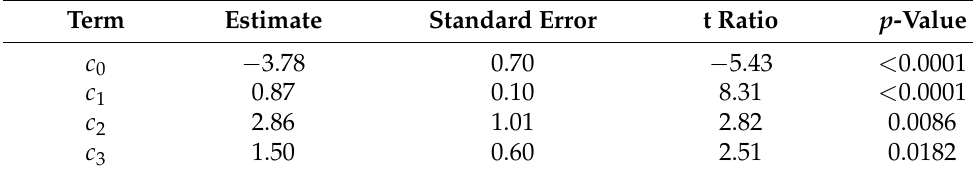
Table 5. Parameters of the multiple regression model ( R 2 = 85.0%) for the prediction of ln ( C T ) . All parameters contribute significantly ( p < 0.05) to the prediction, as shown by the p